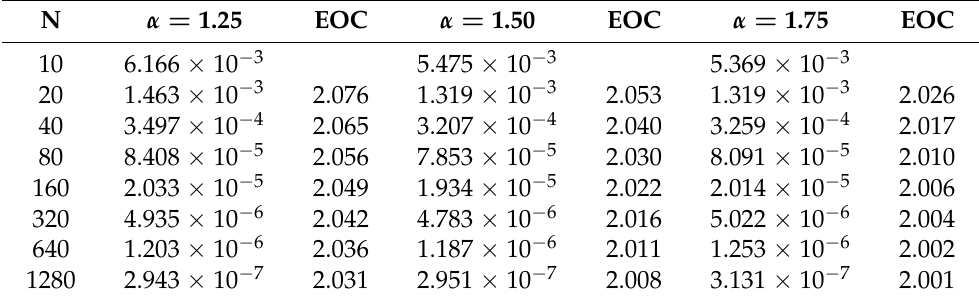
Table 5. Table showing the maximum absolute error and EOC for solving (53) using the predictor– corrector method for α >